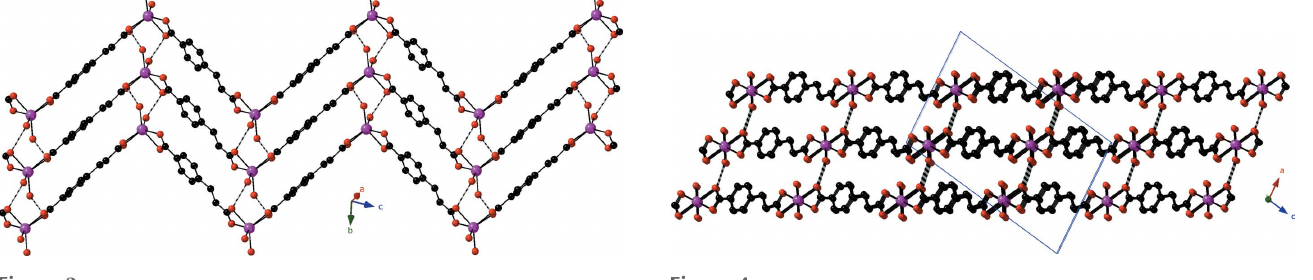
Figure 4 ABA parallel stacking of supramolecular layer motifs in the title compound along [100], mediated by interlayer O—H (cid:2)(cid:2)(cid:2) O interactions, which are shown as dashed lines.